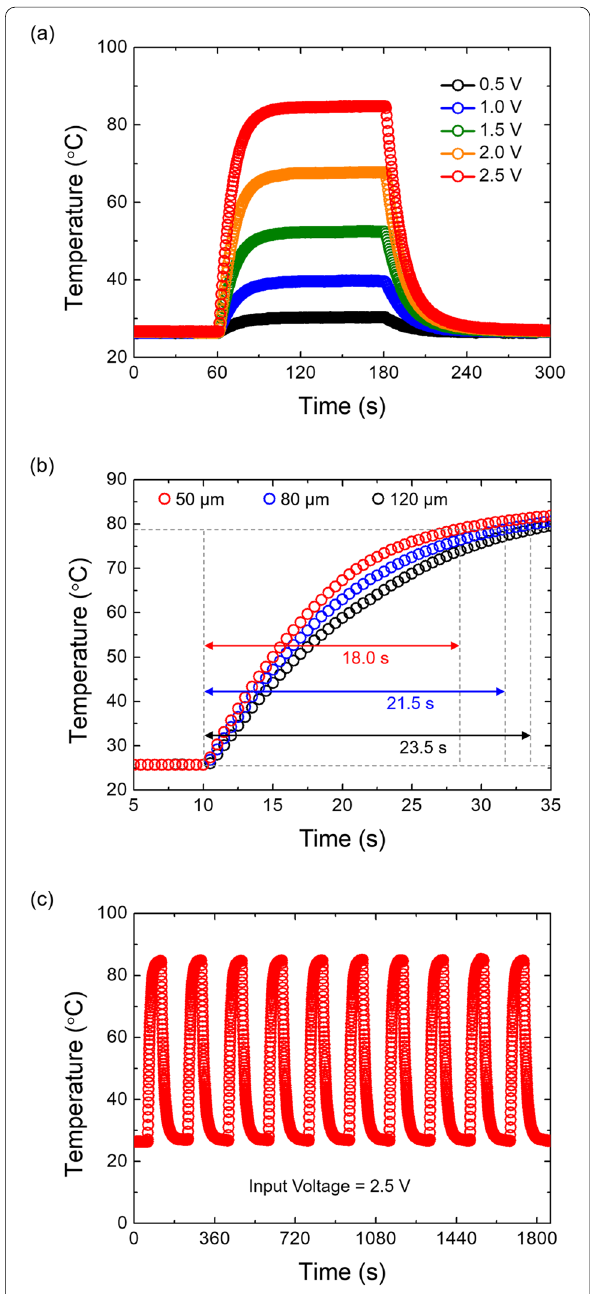
Fig. 5 a Heat generation performance of the Cu mesh/PVA film heater (20 mm 20 mm) as a function of time at an applied voltage × of 0.5, 1.0, 1.5, 2.0, and 2.5 V. b Time–temperature curves of the Cu mesh/PVA film TH of different PVA substrate thicknesses. The time provided in the graphs indicate the response time of the THs. c Results of the cyclic test of the heat generation of the Cu mesh/PVA film heater with an applied voltage of 2.5 V